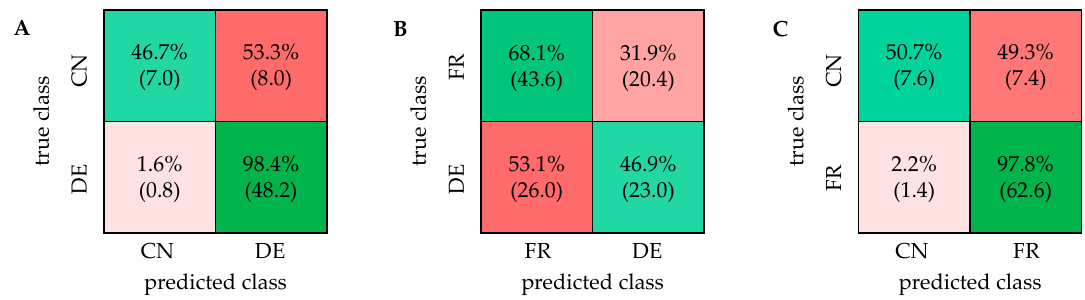
Figure 7. Confusion matrices of all two-class models based on the analysis of the ASAP-HSQC spectra using a linear support vector machine algorithm. CN: China; DE: Germany; FR: France. Accuracies: ( A ): 86.3% (±0.6%); ( B ): 58.9% (±1.3%); ( C ): 88.9% (±1.2%).